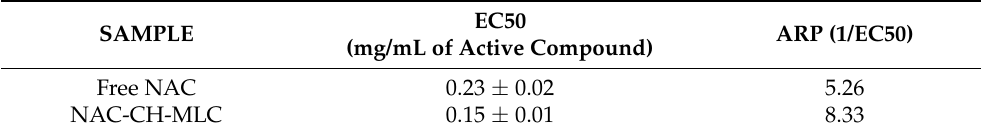
Table 1. EC50 and anti-free radical power (ARP) of free NAC and NAC-loaded MLC. SAMPLE